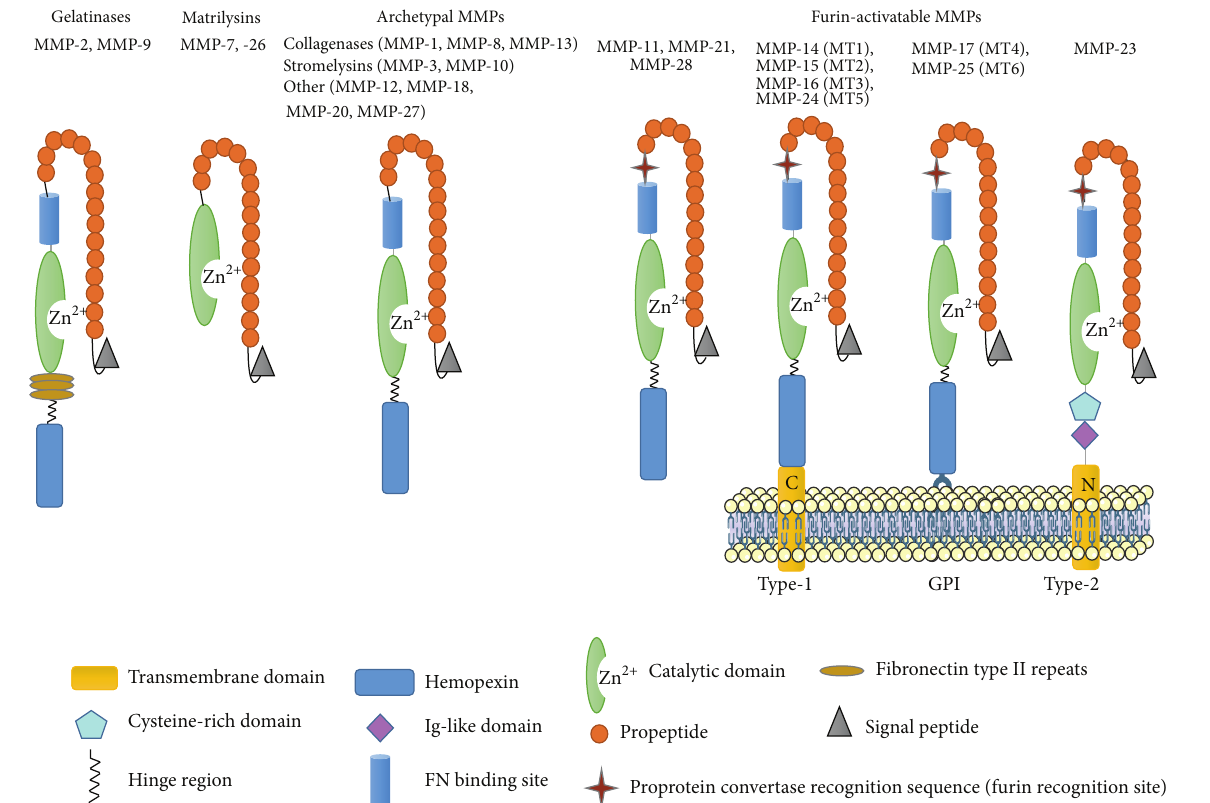
Figure 1: Classification of the MMPs based on their domain organization. MMPs are grouped into four major groups: gelatinases, matrilysins, archetypal MMPs, and furin-activatable MMPs. The typical structure of MMPs consists of a signal peptide, propeptide, a catalytic domain, hinge region, and a hemopexin domain. In addition, members of the gelatinases family have extra fibronectin type II motif repeats in the catalytic domain, and matrilysins have neither a hinge region nor hemopexin domains. Furin-activatable MMPs contain a furin recognition motif and are subcategorized into either secreted or membrane bound. Based on the type of membrane attachment, they are subdivided into type I transmembrane MMPs, GPI-linked MMPs, and type II transmembrane MMPs. Type-II transmembrane MMPs lack a cysteine switch. Instead,theyhaveacysteinerichdomainandIgG-likedomain.C,C-terminaldomain;FN,fibronectin;GPI,glycophosphatidylinositol;MMP, matrix metalloproteinases; N, N-terminal